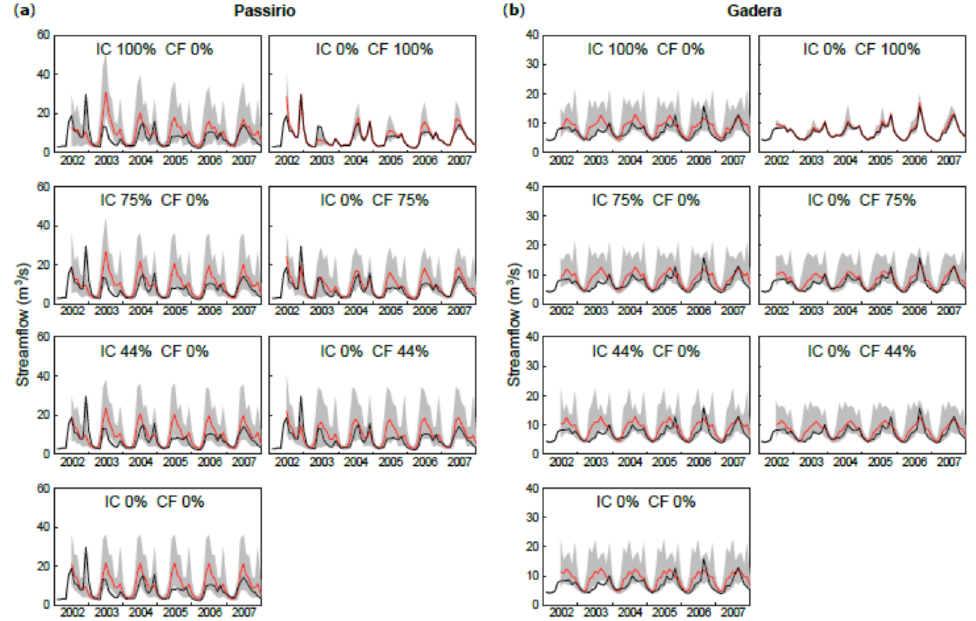
Figure 5. Chained time series of ensemble streamflow forecasts initialized on the first day of each month for varying levels of initial conditions (IC) and climate forcing (CF) skill (assuming null skill in the alternate predictability source), for LT 6 months ( a ) over the Passirio catchment; and ( b ) over the Gadera catchment. Line colors and forecast spreads are explained in Figure 4. Note the difference in the vertical axis between the two case studies.